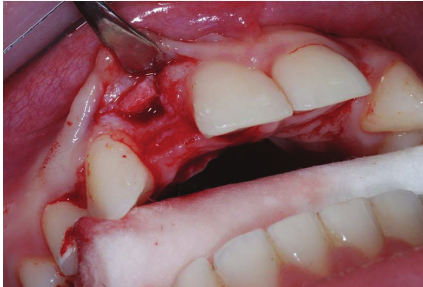
Figure 5: Crestal osteotomy and bone window creation in site to the left.